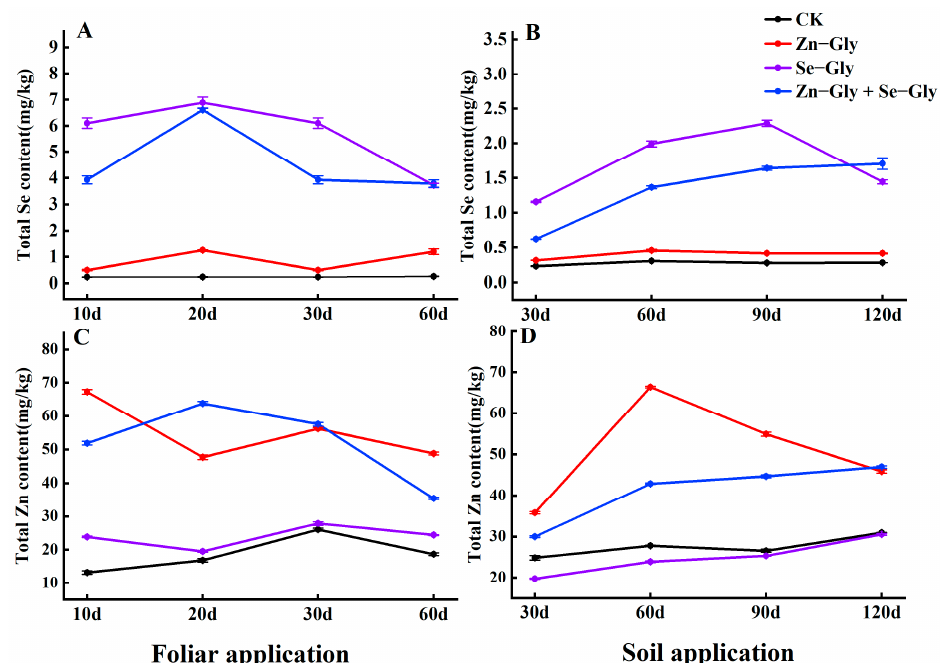
Figure 4. The content of zinc and selenium in tea leaves under different treatments. ( A , C ) Content of zinc and selenium in tea leaves following foliar fertilizer application; ( B , D ) Content of zinc and selenium in tea leaves following soil fertilizer application. The abscissa shows the days of treatment. Different colors represent different treatments, as follows: black, CK; red, Zn − Gly; purple, Se − Gly; blue, Zn − Gly + Se − Gly.